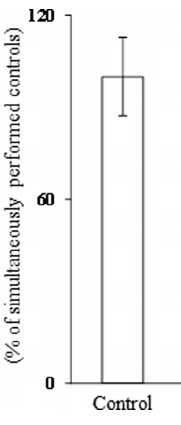
Figure 1. Effect of chronic exposure of pancreatic acinar 266-6 cells to NNK on carrier-mediated [ 3 H] thiamin uptake. The initial rate of carrier-mediated uptake of a physiological concentration of [ 3 H]thiamin (15 nM) by 266-6 cells exposed to NNK (3 m M, 24 h) was determined as described under ‘‘Materials and Methods’’. Each data represents the mean 6 SE of at least three separate uptake determinations. * P , 0.01.